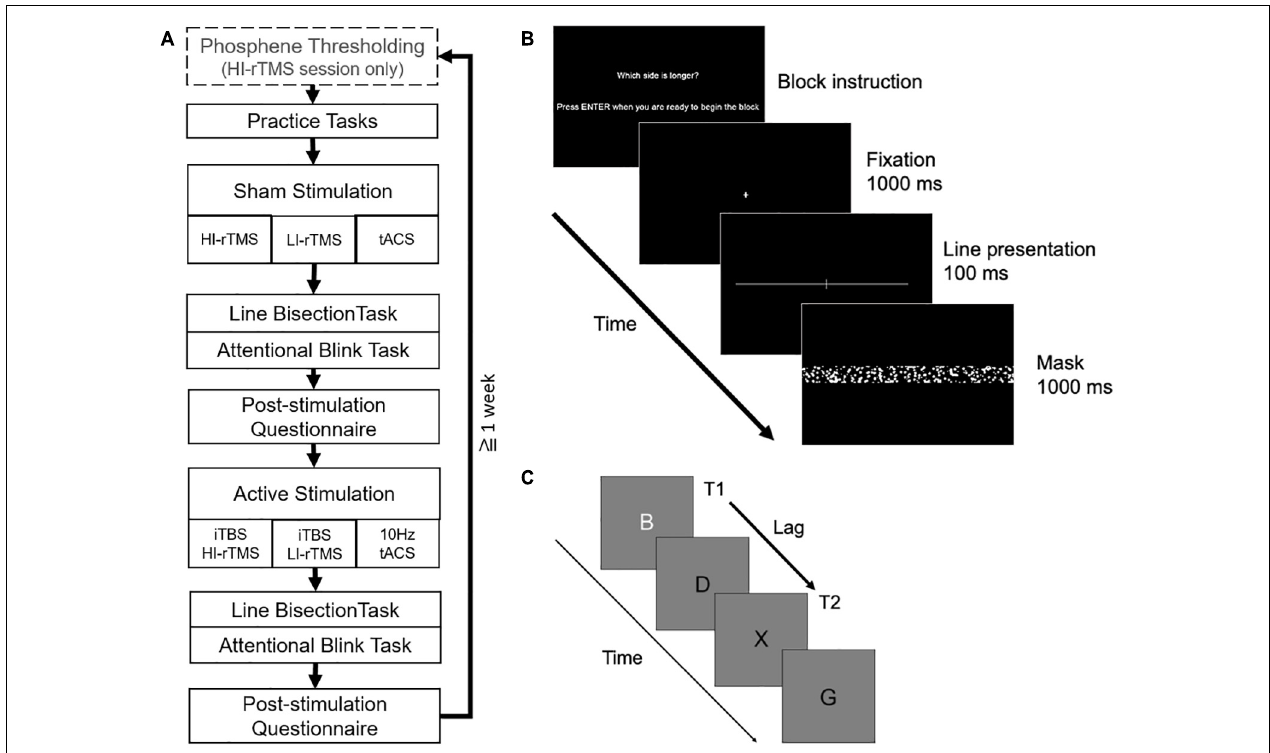
FIGURE 1 | (A) Overall order and structure of each experimental session. (B) Example of a trial in the line bisection task. (C) Example letter sequence in the attentional blink task (T2 shown at lag 2 position).